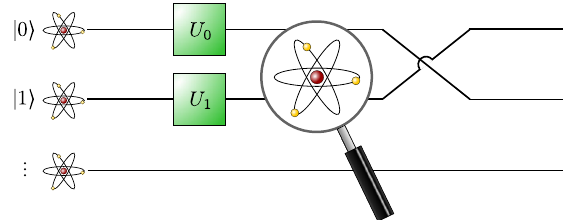
FIG. 2. Strictly incoherent operations viewed as operations on a particle traveling through an interferometer. The different branches j i i span the Hilbert space H B , while the internal state of the particle has Hilbert space H I . The operations are built up by combining path-dependent unitary operations U i on and measurements of the internal state of the particle, as well as permutations of the